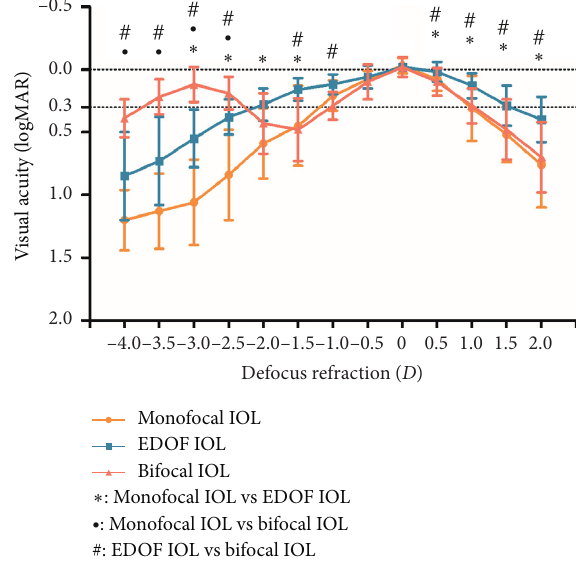
Figure 2: The defocus curves in the 3 intraocular lens (IOL) groups. Bars around data points correspond to the standard deviation (SD) ( ∗ � statistically significant difference between the monofocal group and the extended range of vision (EDOF) group [ P < 0 . 05 ] ; ● � statistically significant difference between the monofocal group and the bifocal group [ P < 0 . 05 ] ; # � statistically significant dif- ference between the EDOF group and the bifocal group [ P < 0 . 05 ] ; logMAR � logarithm of minimum angle of